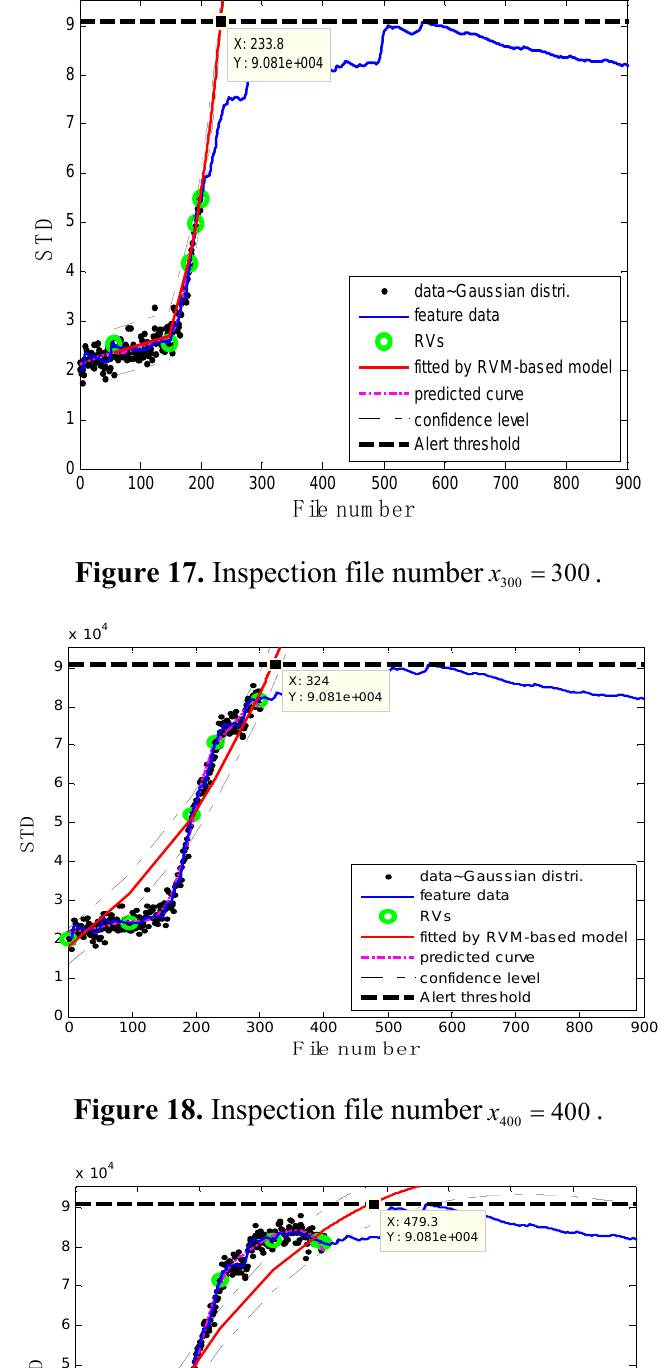
Figure 16. Inspection file number